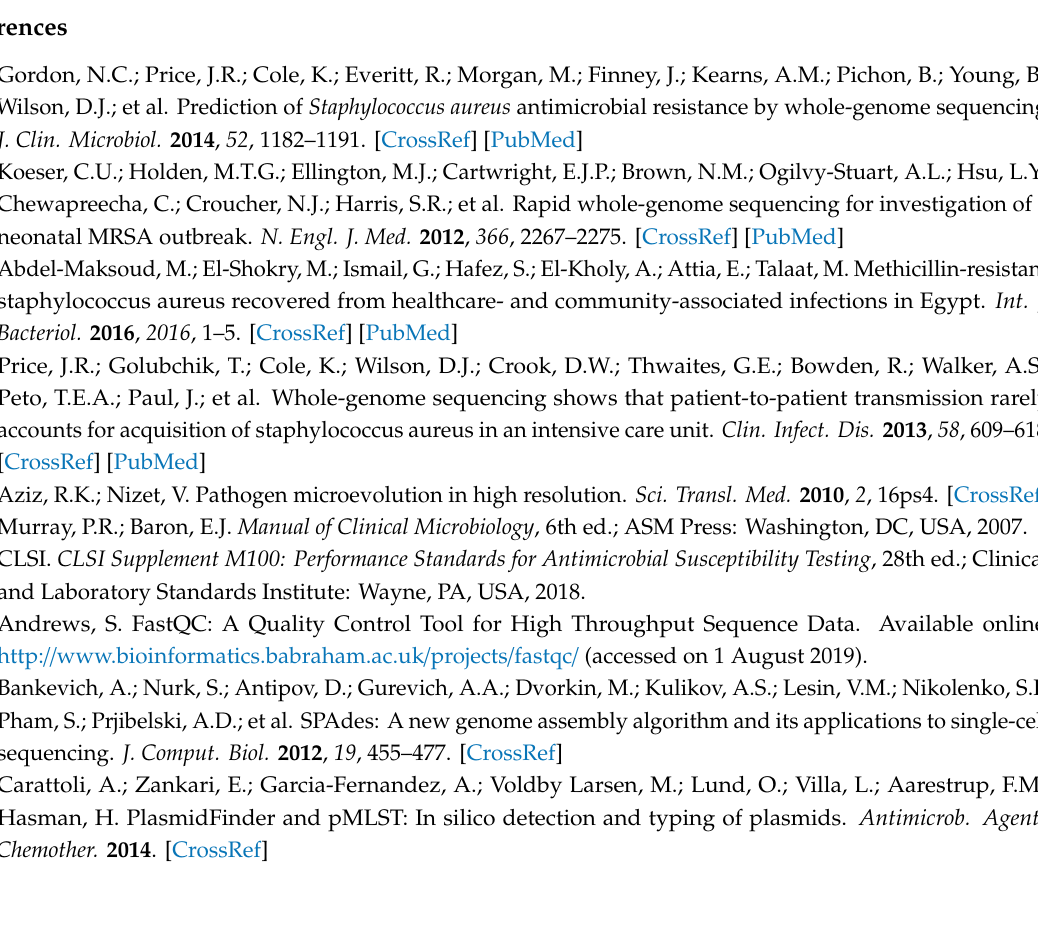
Figure S1: Two separate correlation matrices (similar to the one in Figure 3) separately indicating all correlations between pairs of virulence genes, as well as pairs of genetic or phenotypic resistance determinants. Shades of blue represent positive correlations, while shades of orange / red represent negative correlations. Table S1: Clinicoepidemiological characteristics of all isolates as well as their deduced sequence types, resistance genes (resistome), virulence genes (virulome) and resistance phenotypes. Table S2: p -values for comparisons of all pairs of categorical traits using Fisher’s exact test. The table cells are color-coded for significance with di ff erent shades of pink or red. Supplementary Data Sheet 1: Contingency tables and the full results of Fisher’s exact test between pairs of categorical variables which passed the significance threshold ( p -value <